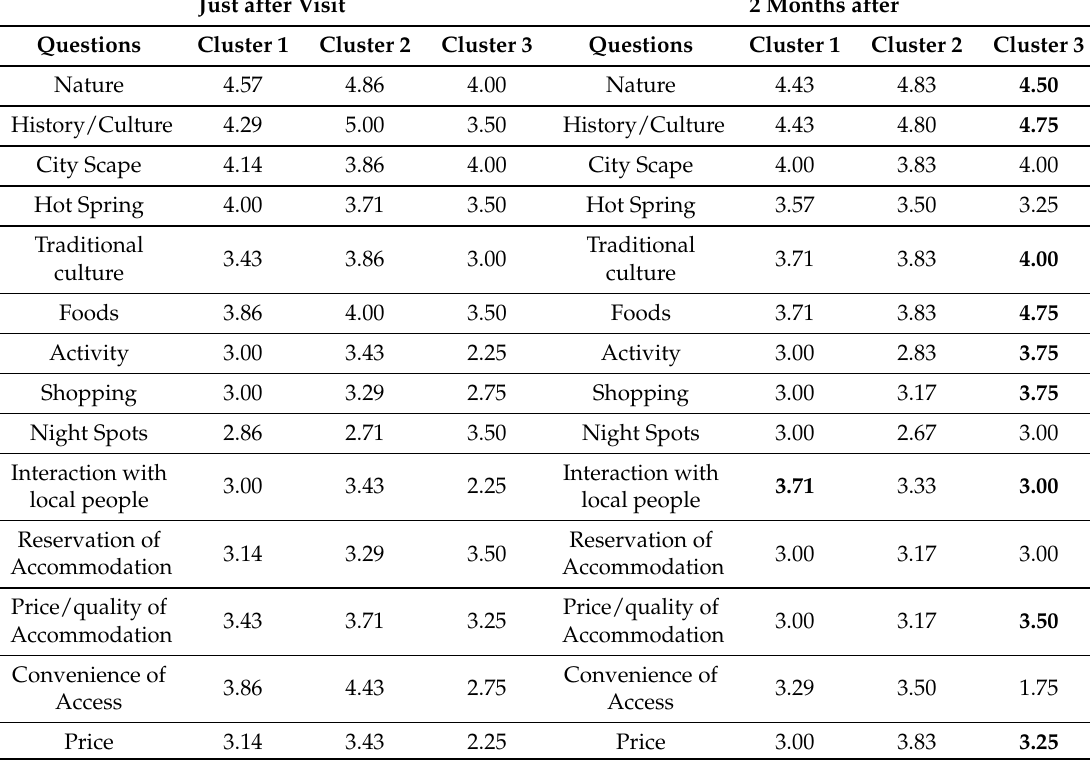
Table 1. The difference of impression of Nikko results after two months.